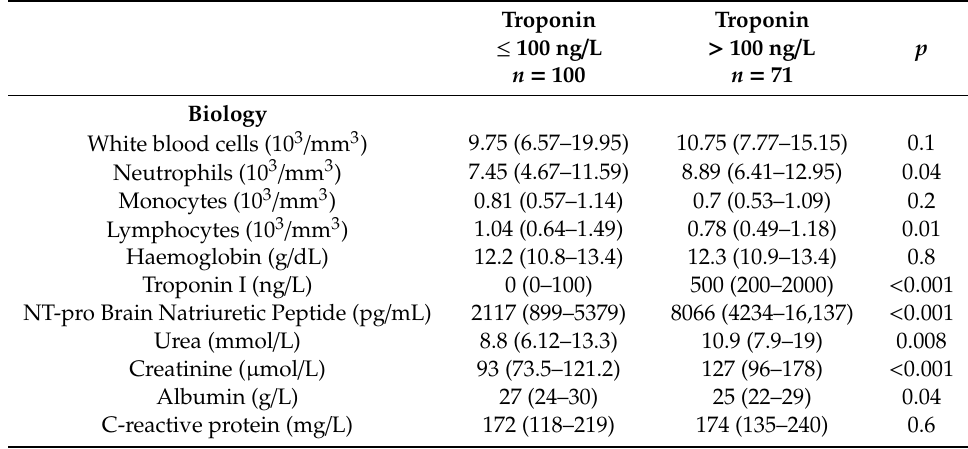
Table 2. Biological and microbiological data at admission of older in-patients with acute pneumonia ( n (%) or median (interquartile